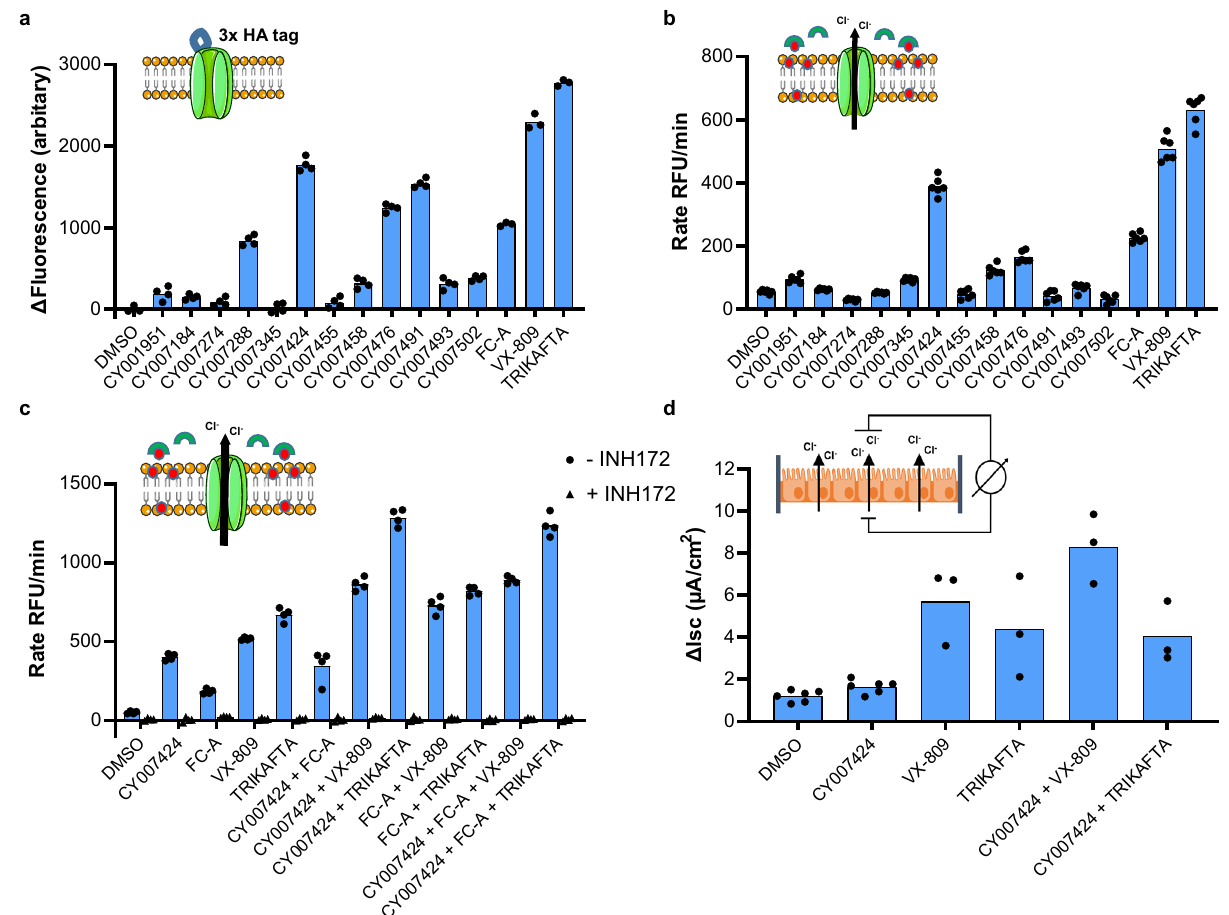
Fig. 5 Cellular activity of macrocycles stabilizing the 14-3-3/CFTR PPI. a Surface expression of 3HA-tagged F508del-CFTR in BHK cells incubated for 24 h with 10 μ M compound and treated with mouse monoclonal anti-HA antibody and anti-mouse IgG conjugated with FITC ( n = 4 or n = 3 biological replicates, bars represent the mean). b , c FLIPR Membrane Potential (FMP) assay of F508del-CFTR expressing BHK cells treated for 24 h with the macrocycles ( b , n = 6 biological replicates, bars represent the mean) or with CY007424 and/or VX-809 or Trikafta ® , with and without CFTR inhibitor INH172 ( c , n = 4 biological replicates, bars represent the mean). d Using chamber experiment of F508del-CFTR expressing CFBE cells treated for 18 h with CY007424, VX-809, or Trikafta ® or in combinations. CFTR activity is assayed by measurement of short-circuit current of cells after stimulation by forskolin and the potentiator genistein ( n = 3 or n = 6 biological replicates, bars represent the mean). Source data are provided as a Source Data fi